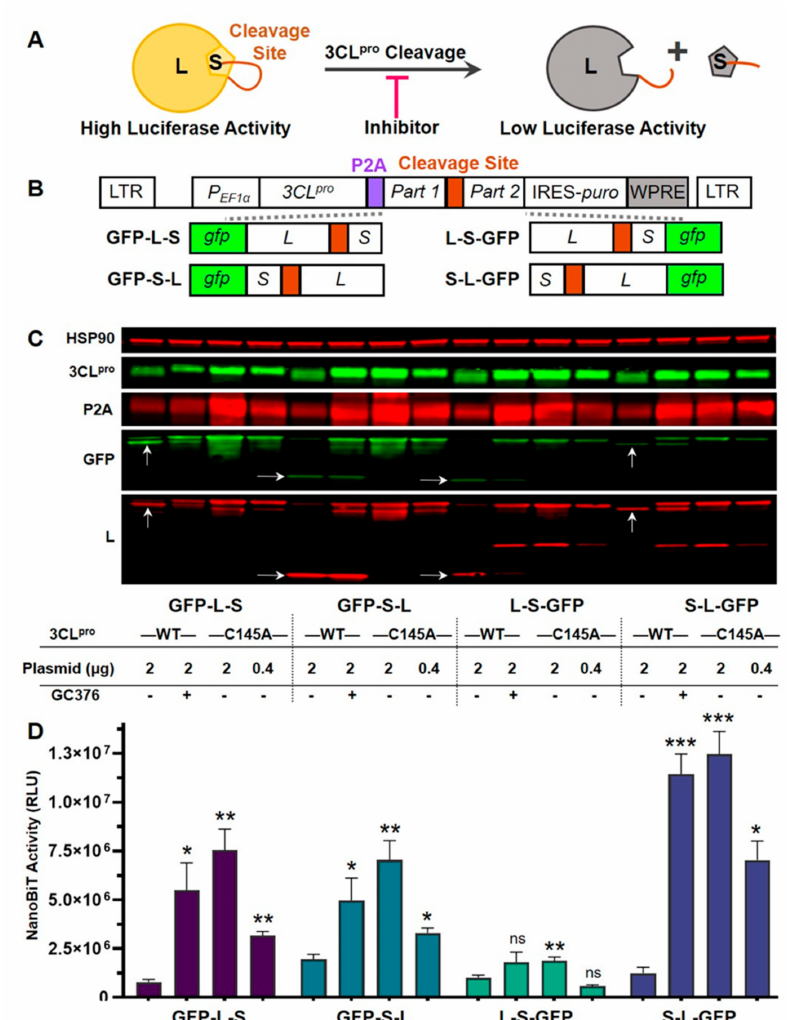
Figure 1. Development of cell-based luciferase complementation reporters to detect inhibition of SARS-CoV-2 3CL pro activity. ( A ) Strategy for detection of 3CL pro inhibition using NanoBiT, a luciferase complementation reporter comprised of Large BiT (L) and Small BiT (S). When connected by a linker containing a 3CL pro cleavage site, 3CL pro cleavage should result in a loss of complementation and low luciferase activity. Conversely, 3CL pro inhibitors should prevent cleavage, resulting in high luciferase activity. ( B ) Lentiviral vectors that express 3CL pro and reporters. P2A, a self-cleaving peptide, was inserted between 3CL pro and reporters. Reporters consisted of GFP linked to L and S in various orders. L and S